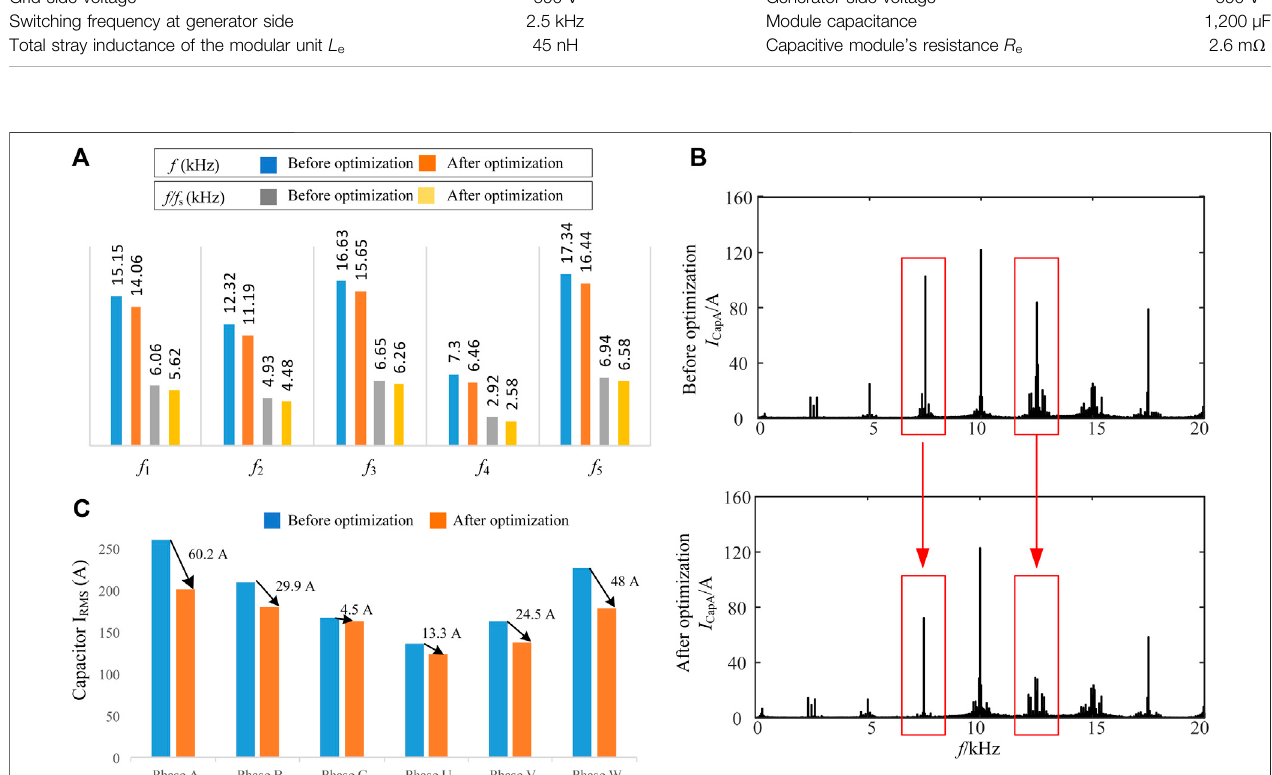
FIGURE12|(A) Resonancefrequenciesoftheimpedancenetworkbeforeandafteroptimization (B) ComparisonofphaseAcapacitorcurrentspectrumofbusbar (C) Comparison of capacitor current RMS value of each phase.